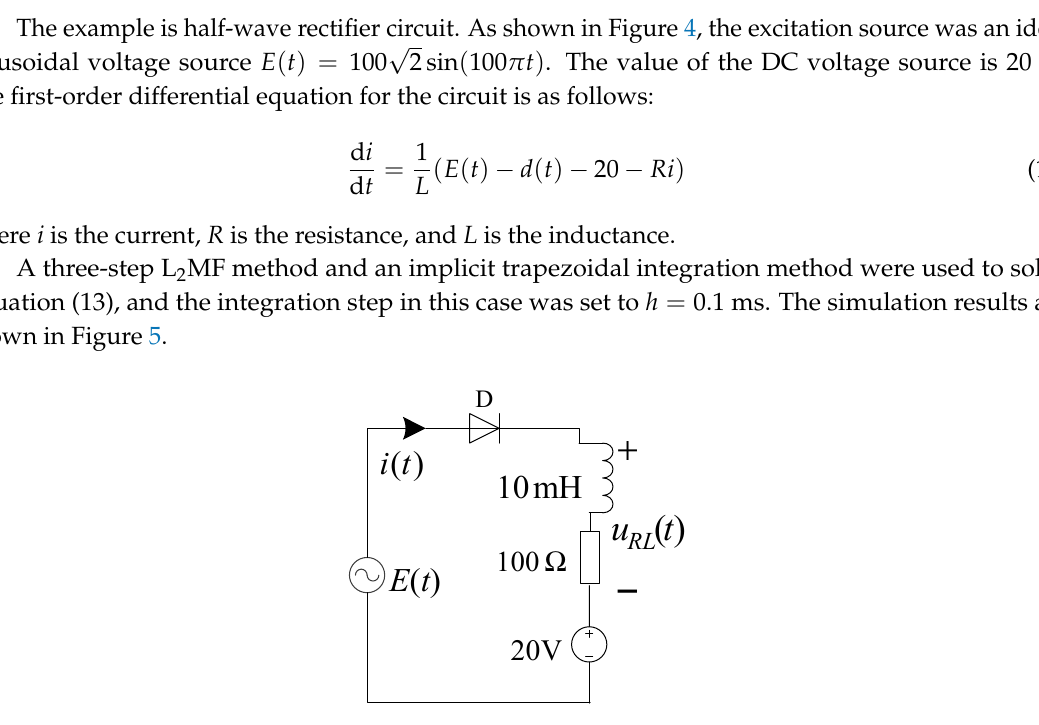
Figure 4. Half-wave rectifier circuit. D represents the diode, which is an ideal switching device with voltage described as d ( t ). u RL ( t ) denotes a load voltage.